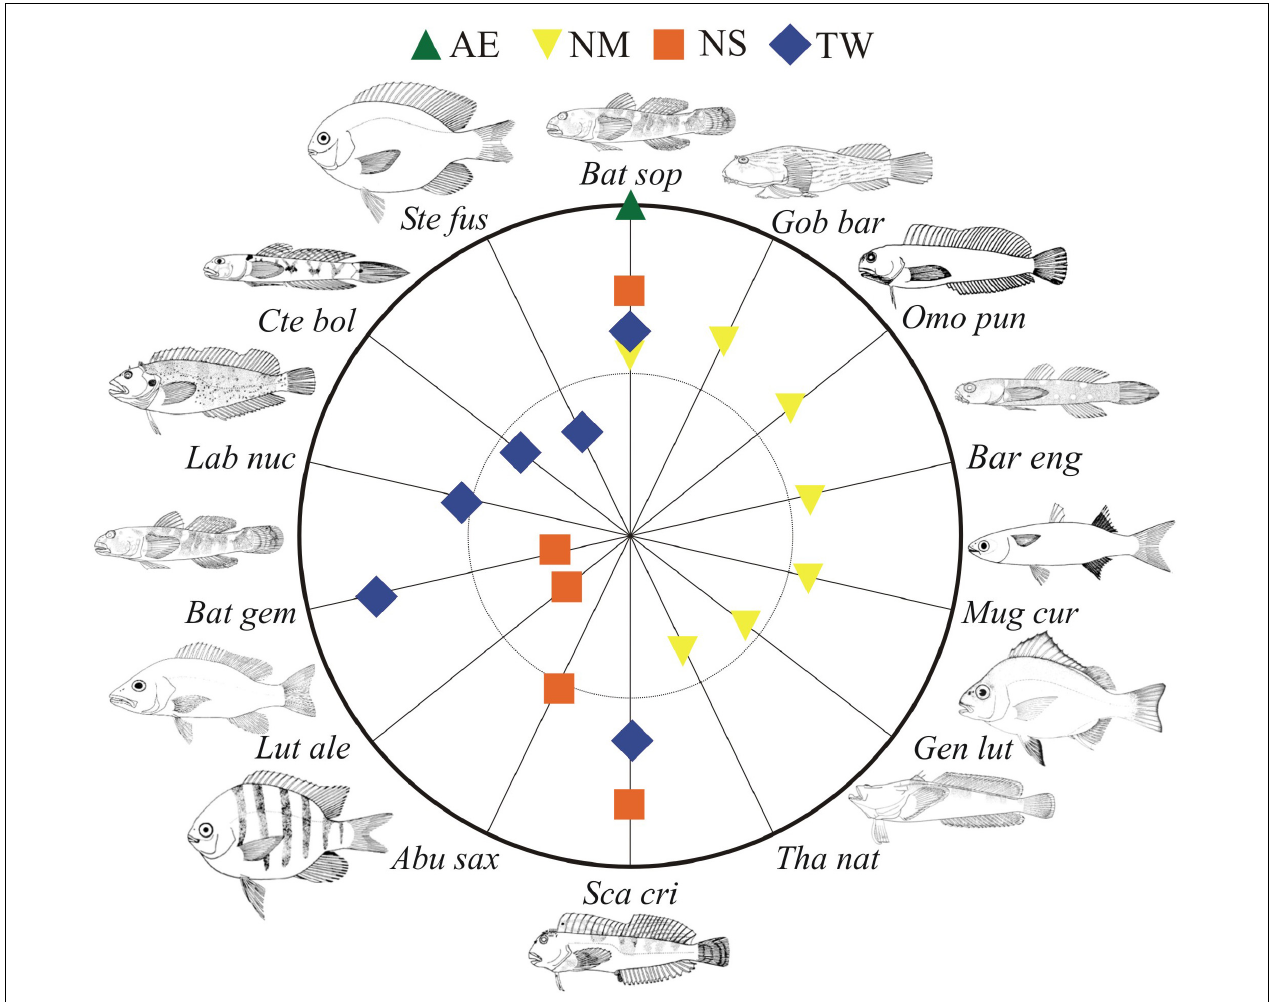
FIGURE 3 | Percentage contributions (log scale; 0 – center, 10 – inner circle and 100 – outer circle) of the most important fish species to the typical “subprovinces,” based on the SIMPER analysis. Subprovinces: AE, Amazon estuary; NM, Northern mangrove; NS, Northeastern semiarid; TW, Tropical warm. Bat sop , Bathygobius soporator ; Gob bar , Gobiesox barbatulus ; Omo pun , Omobranchus punctatus ; Bar eng , Barbulifer enigmaticus ; Mug cur , Mugil curema ; Gen lut , Genyatremus luteus ; Tha nat , Thalassophryne nattereri ; Sca cri , Scartella cristata ; Abu sax , Abudefduf saxatilis ; Lut ale , Lutjanus alexandrei ; Bat gem , Bathygobius geminatus ; Lab nuc , Labrisomus nuchipinnis ; Cte bol , Ctenogobius boleosoma ; Ste fus , Stegastes fuscus